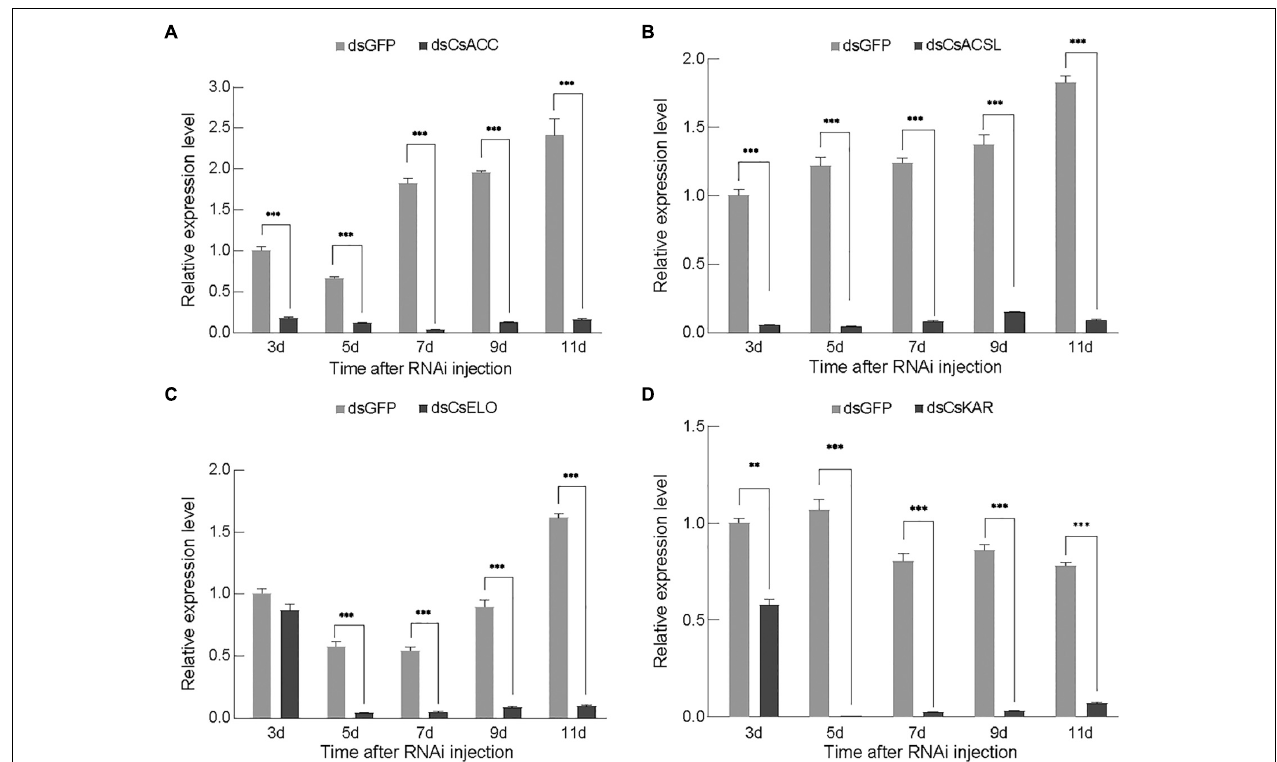
FIGURE 3 | Relative gene expression of CsACC (A) , CsACSL (B) , CsELO (C) , and CsKAR (D) after dsRNA injection. Data are presented as mean ± SE. Significance analyses were performed using Tukey’s post-hoc test (mean ± SE; ∗∗ P < 0.05; ∗∗∗ P < 0.01). Different letters indicate a significant difference between stages ( P < 0.05). **Indicated significant difference between experimental group and control group ( P < 0.05). ***Indicated that the difference between experimental group and control group was extremely significant ( P < 0.01).